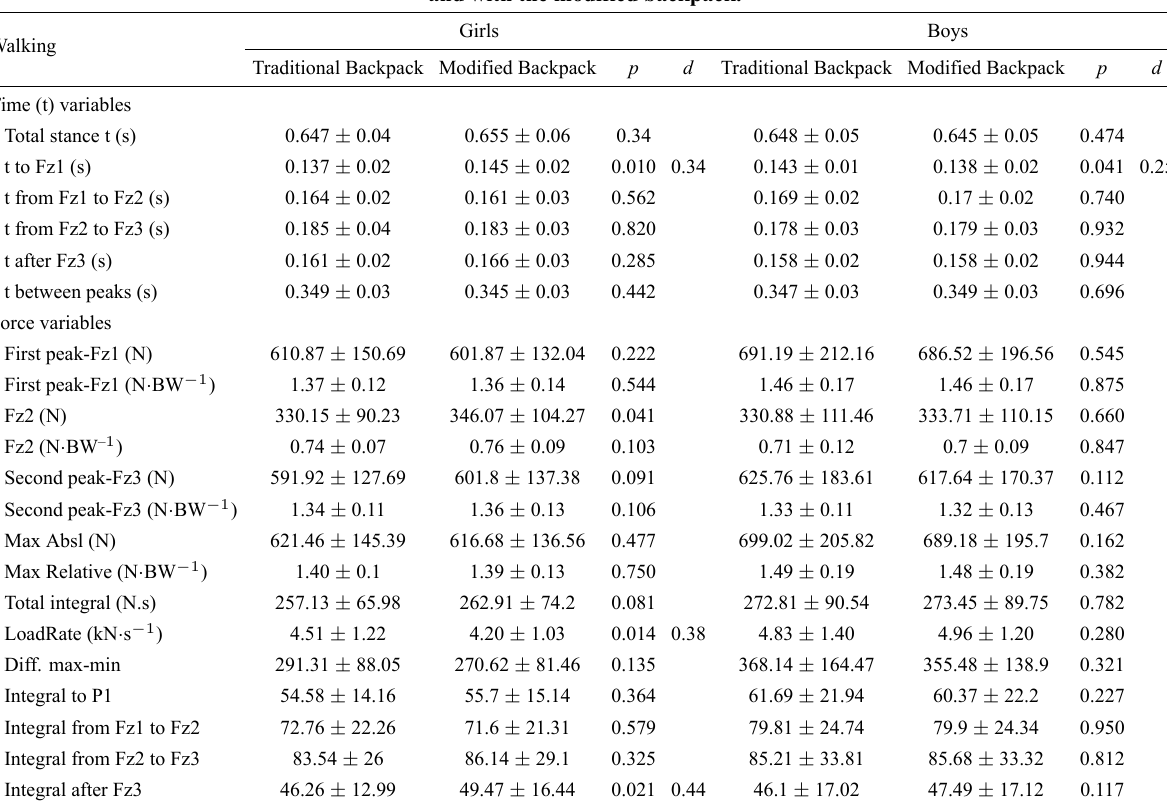
Table 3. Time and force variables (mean ± standard deviations) for boys and girls while walking with the traditional backpack and with the modified backpack.